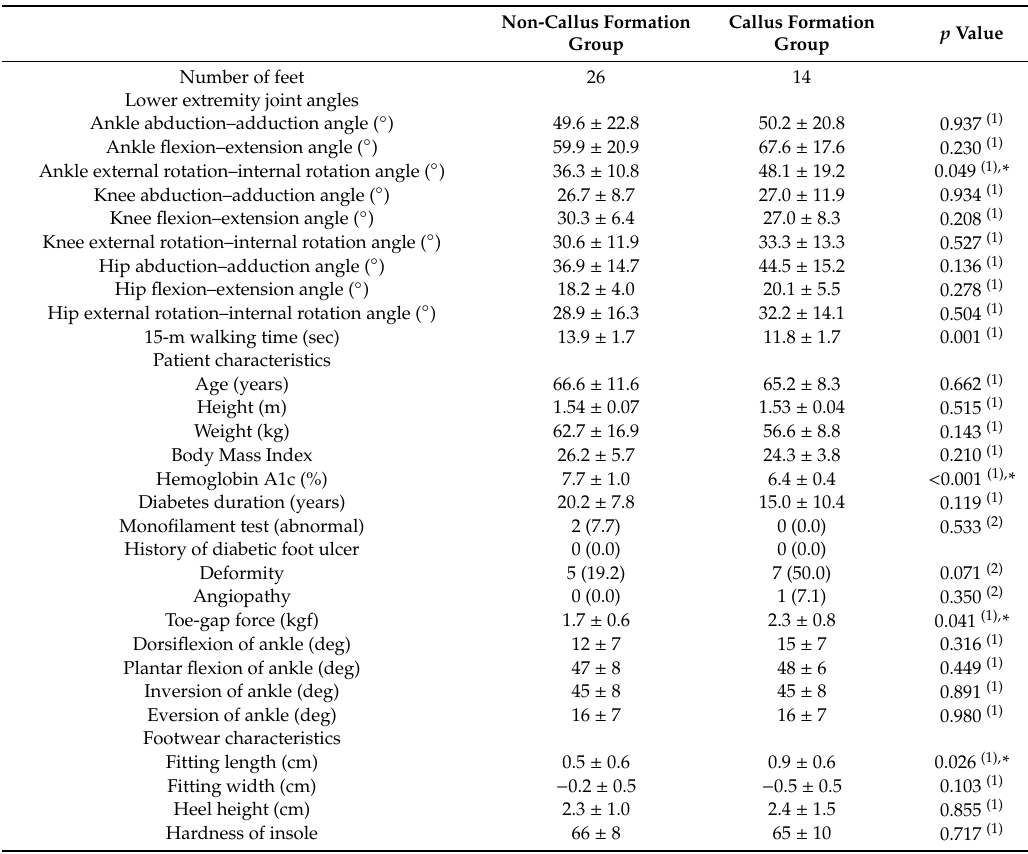
Table 3. Comparison of all data for the second metatarsal head in female patients.